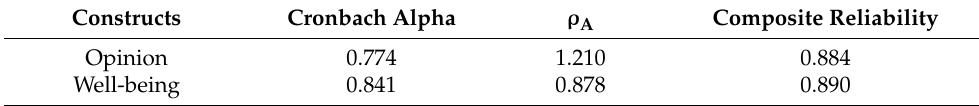
Table 3. Construct reliability